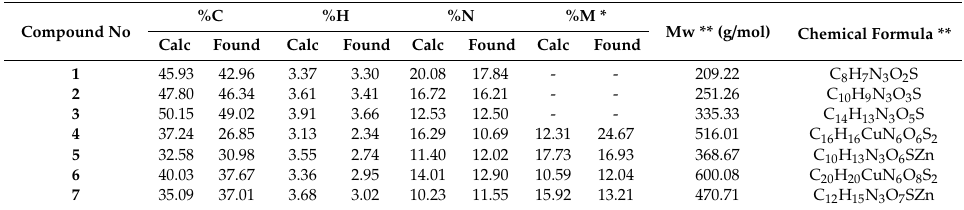
Table 4. Microanalysis (C,H,N), AAS, molecular weight, and chemical formulae of thiadiazole derivatives 1 – 7